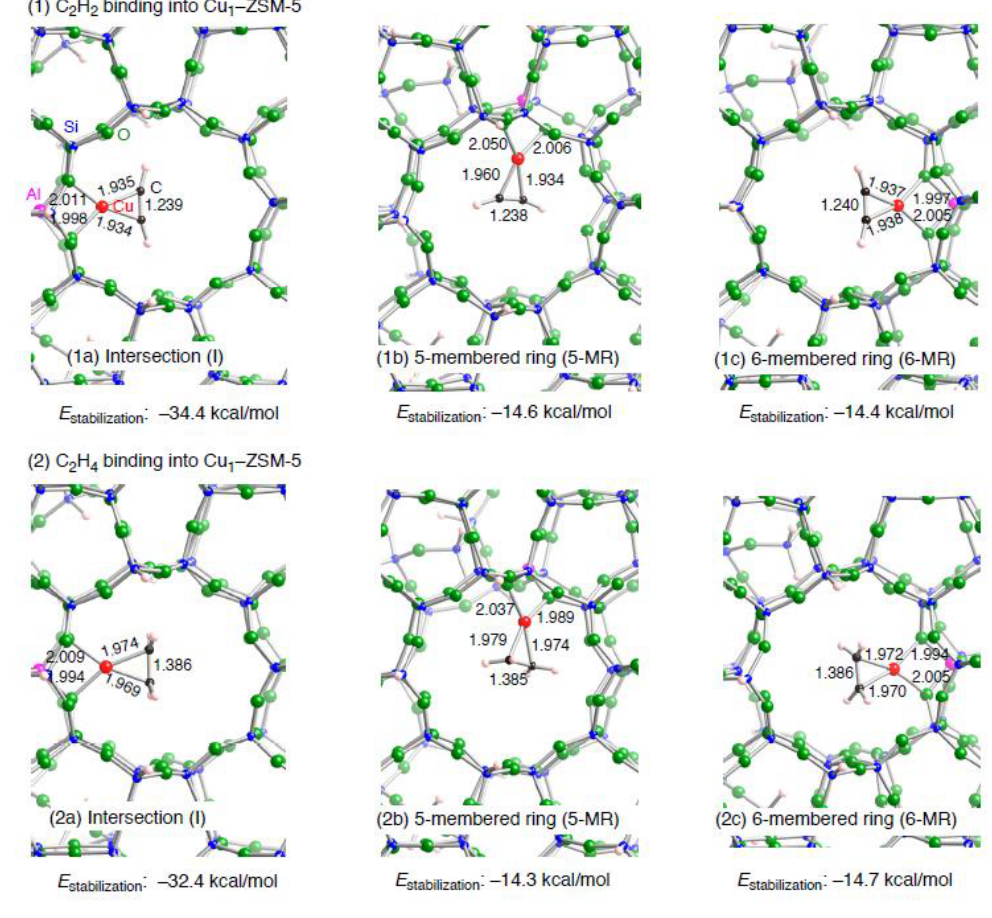
Figure 4. Local structures of three optimized structures for the binding of an unsaturated hydrocarbon ((1) C H or (2) C H ) into a monocopper cation embedded inside the 2 2 2 4 AlSi O H ZSM-5 model. (a) the copper cation sits at the intersection between 91 151 66